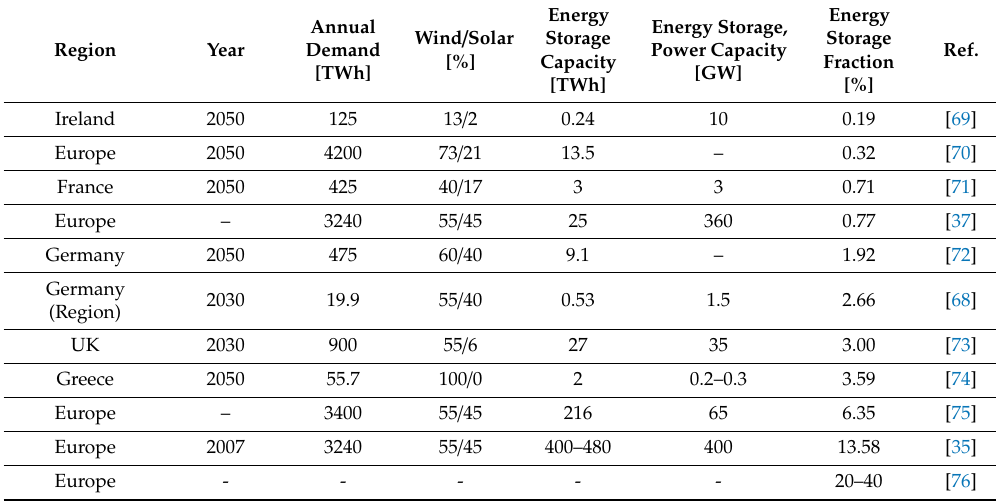
Table 5. Recommended annual storage features in Europe, with a renewable energy sources (RES) penetration of 100% based on